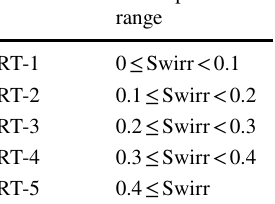
Rock type Rock differen- tiation parameter